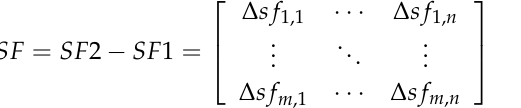
Figure 5. Randomly select the mean of the difference between 400 AAC audio.